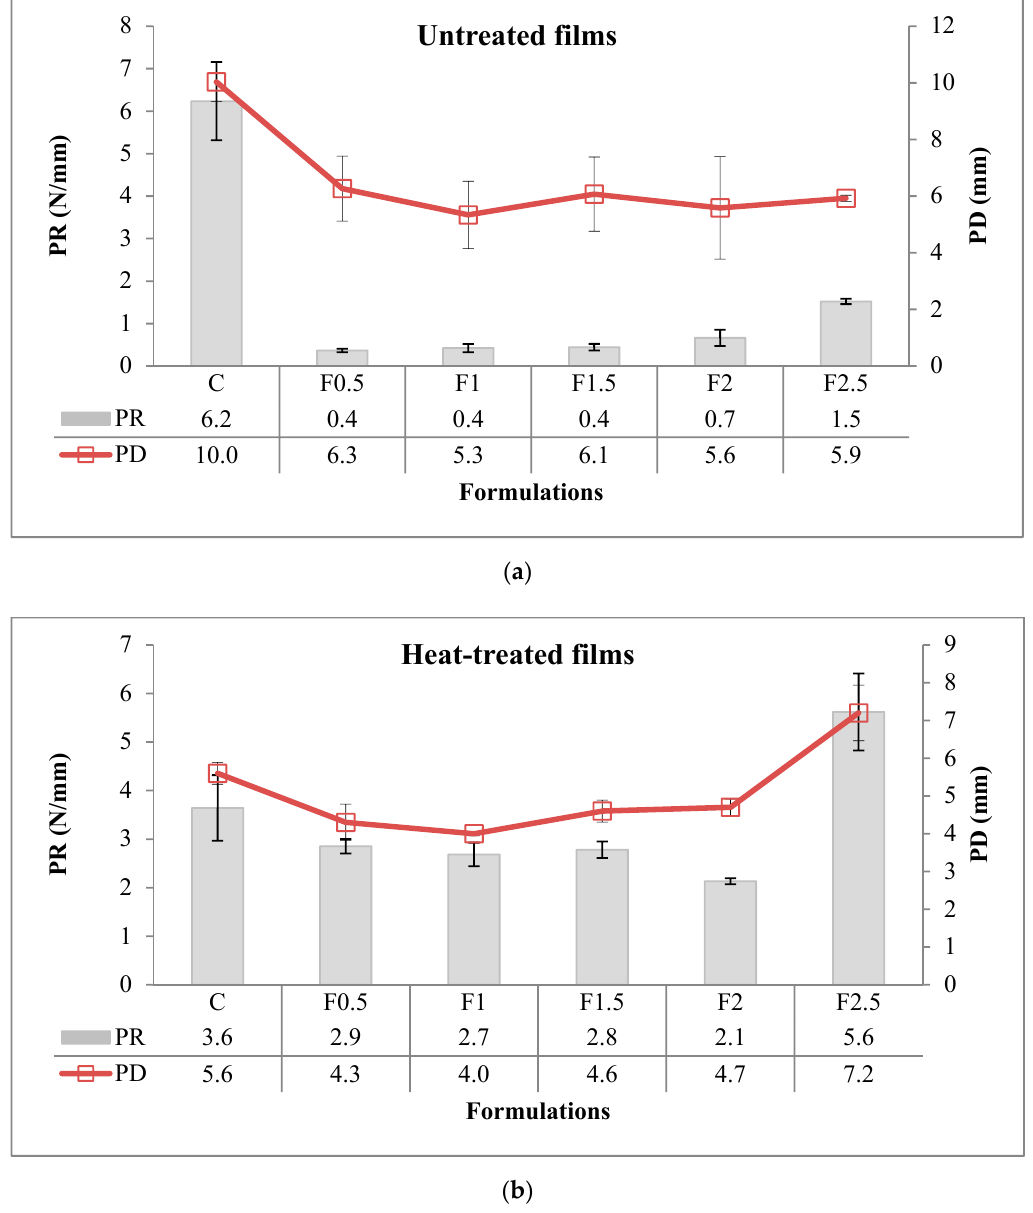
Figure 9. Puncture resistance (PR) and puncture deformation (PD) of edible films. ( a ) Untreated, ( b ) heat-treated. C-control film; F0.5-film with 0.5% tarragon essential oil; F1-film with 1% tarragon essential oil; F1.5-film with 1.5% tarragon essential oil; F2-film with 2% tarragon essential oil; F2.5-film with 2.5% tarragon essential oil. Values are expressed as mean ± standard deviation of four replicates for PR and